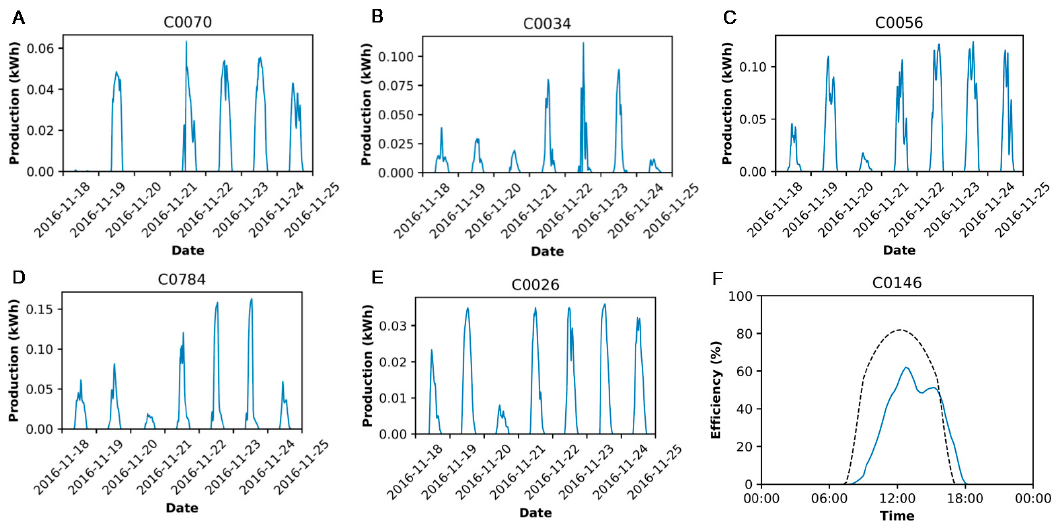
Figure 8. Examples of photovoltaic (PV) systems detected with production anomalies under adverse weather conditions. ( A ) PV system with sustained daytime zero-production; ( B ) PV system with brief daytime zero-production; ( C ) PV system with daytime shading; ( D ) PV system with sunrise and sunset shading; ( E ) PV system with low maximum production; and ( F ) PV system with suboptimal orientation.